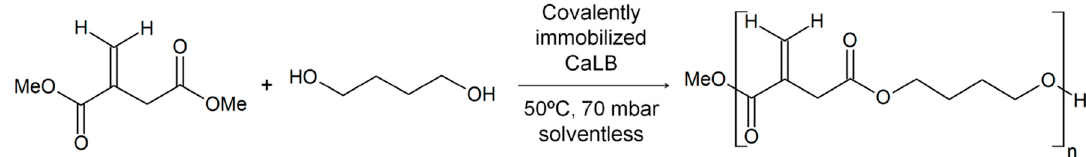
Figure 9. Solvent-free polycondensation catalyzed by CaLB covalently immobilized on RH.